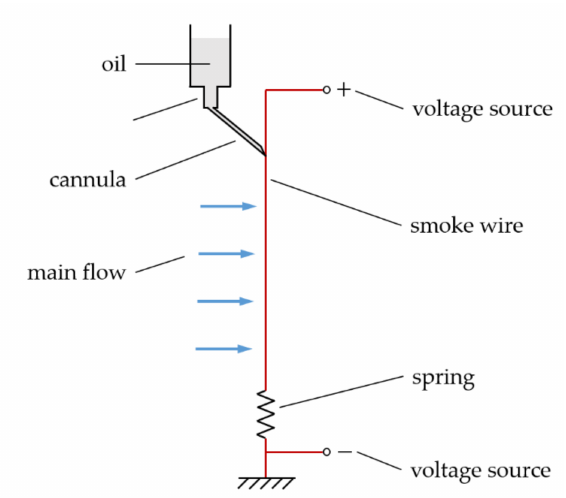
Figure 13. Principle of the smoke wire flow visualization